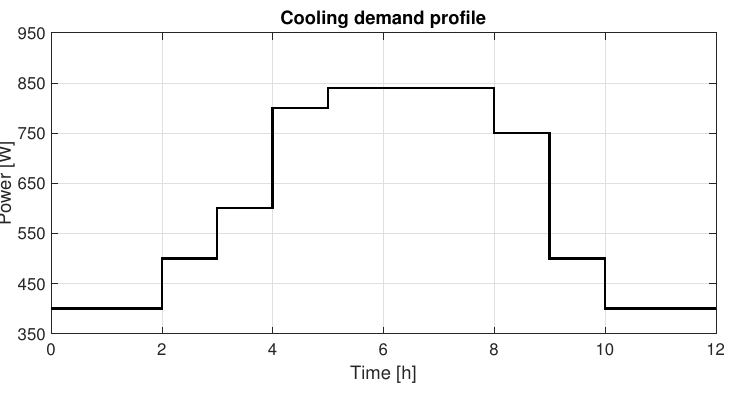
Figure 7. Cooling demand